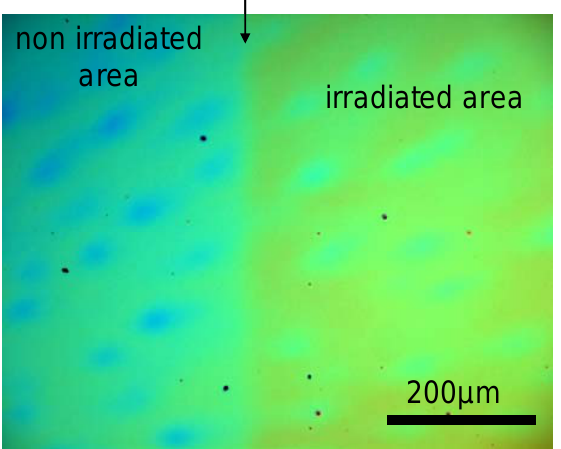
Figure 1. Optical micrograph of the surface of a thin poly(acrylic acid- co -allylacrylate) layer. (molar ratio 90/10). The film was cast from 10 wt % THF solution and irradiated with a UV lamp (6 mW/cm 2 ) for 4 hours through a shadow mask. The arrow indicates the border between the irradiated and non-irradiated